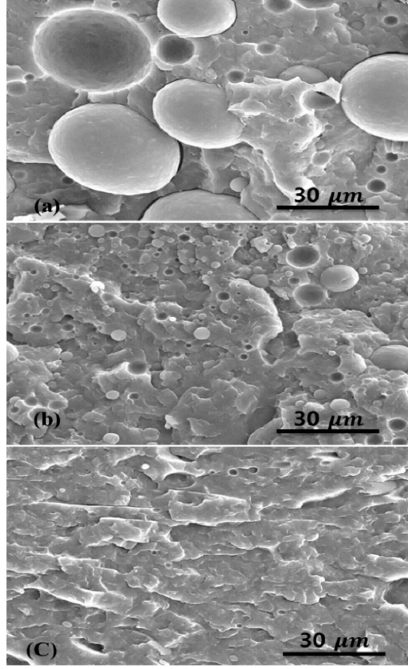
Figure 1. SEM images of cryofractured surfaces of PA6/PP (80/20) blends irradiated at 0 kGy ( a ); 20 kGy ( b ); and 200 kGy ( c ).